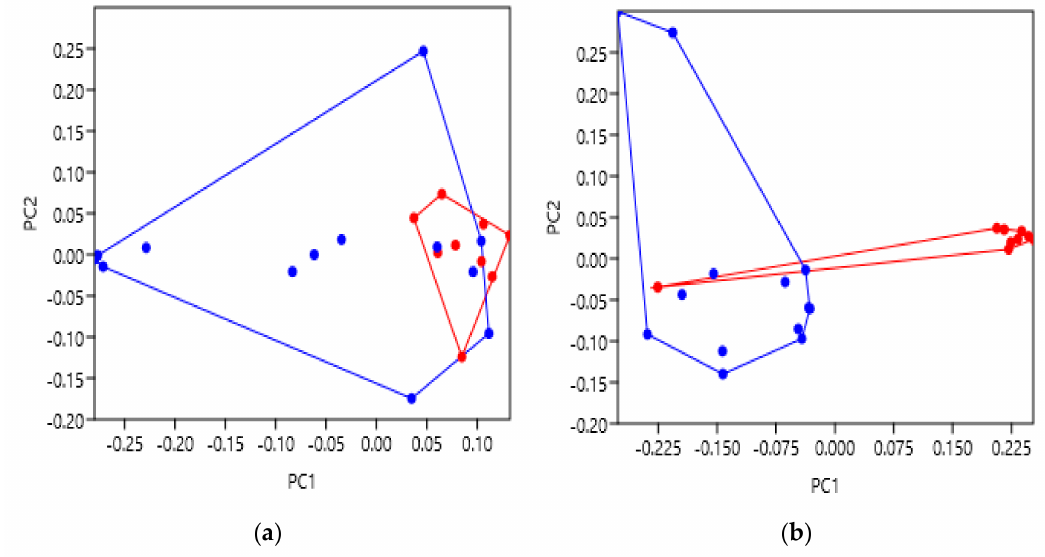
Figure 5. Principal component analysis to show the orexin receptor shape variation with a glycogen synthase fusion protein or not. Those with a glycogen synthase fusion are indicated in red, and those with no fusion are blue. ( a ) PC score comparison for the extracellular face of the orexin receptors transmembrane bundle. ( b ) PC score comparison for the intracellular face of the orexin receptors transmembrane bundle. The supporting statistical data are summarised in Tables 6 and 7. Additional supporting figures are found in Appendix B Figure